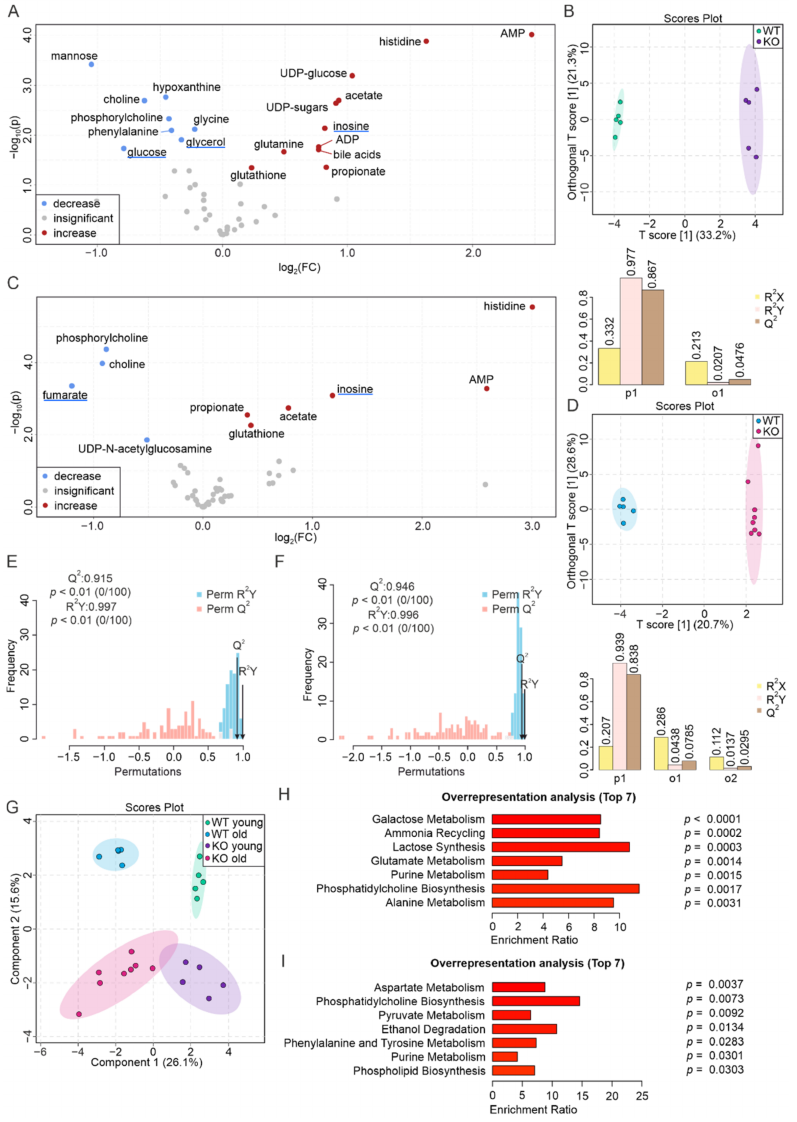
Figure 1. Drastic alteration of liver metabolome as a consequence of PEMT deficiency. ( A ) Volcano plot showing the differences in metabolite levels between WT and PEMT KO livers from young mice (normalization was performed for each pairwise comparison). Red and blue dots represent significantly increased and decreased metabolites ( p < 0.05), respectively, whereas grey dots represent metabolites with insignificant changes ( p > 0.05). Blue and red underlines indicate aging biomarker(s) whose concentration(s) decrease(s) and increase(s) in the WT aged liver, respectively, as well as in (C). ( B ) O-PLS-DA plot of WT ( n = 5, green) and KO ( n = 5, purple) liver samples from young mice (upper panel) and cross-validation coefficients R2X, R2Y, and Q2 of the first predictive component (p1) and the first orthogonal component (o1) (lower panel). ( C ) Volcano plot showing differences in the abundance of metabolites between WT and PEMT KO livers from aged mice. ( D ) O-PLS-DA plot of WT ( n = 5, blue) and KO ( n = 8, pink) liver samples from aged mice (upper panel) and model quality assessment for p1 and o1 with cross-validation coefficients R 2 X, R 2 Y, and Q 2 (lower panel). ( E ) Histogram for the permutation test of the samples in ( B ) and ( F ) of the samples in (D) with permutation number n = 100, respectively. ( G ) S-PLS-DA plot showing the clustering of samples from the four liver groups, with green, blue, purple, and pink corresponding to WT young, WT old, KO young, and KO old, respectively. ( H ) ORA of top 7 pathways associated with significantly altered metabolites in livers of young mice ( A ), and ( I ) ORA of top 7 pathways associated with significantly altered metabolites in aged mice ( C ) with all pathways yielding p <